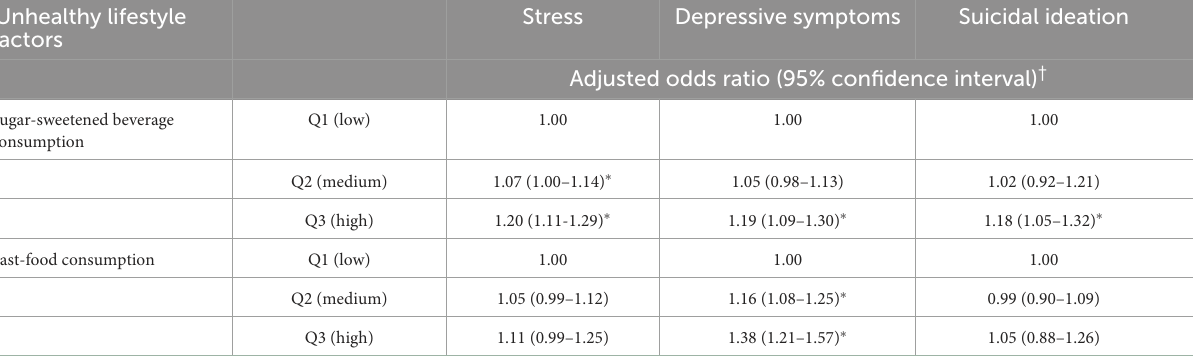
Stress Depressive